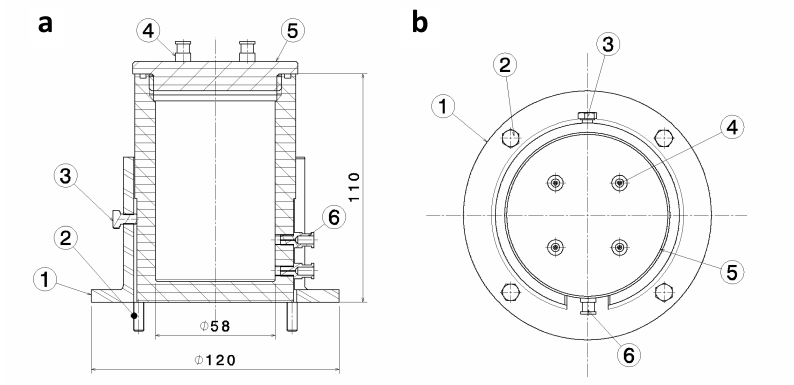
Figure 5. Transversal section ( a ) and top view ( b ) of the media reservoir of the bioreactor with a stub (1) screwed to the ground plate (2), a Teflon screw (3), M5-Luer-Lock adapters (4) in the cap (5) and further M5-Luer-Lock adapters (6) in the bottom. a